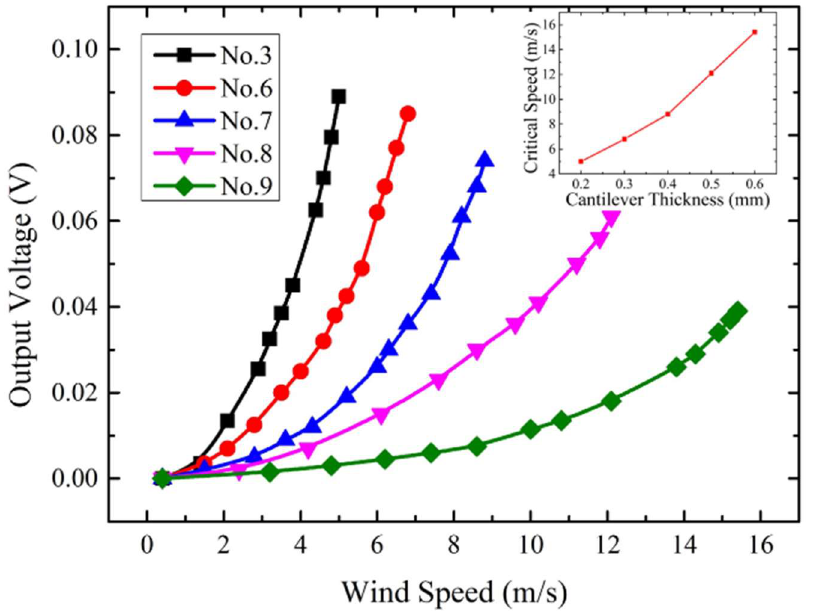
Figure 5. Experimental output voltage versus wind speed characteristics for prototypes with differ- ent thicknesses.